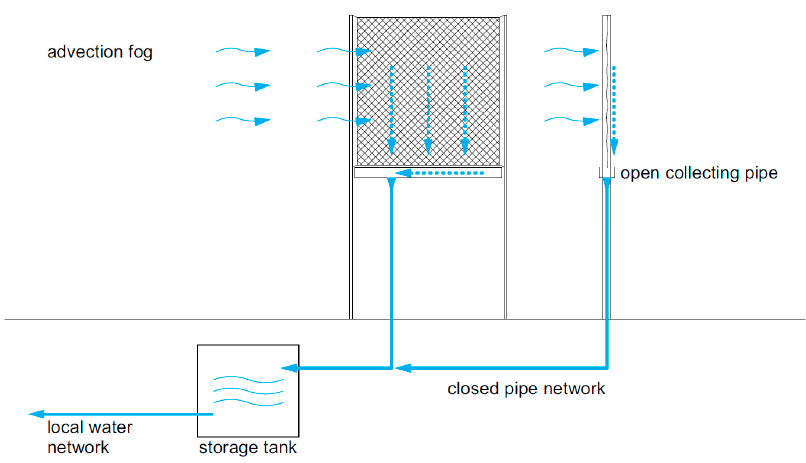
Figure 9. Scheme of a fog collector. Source: author .